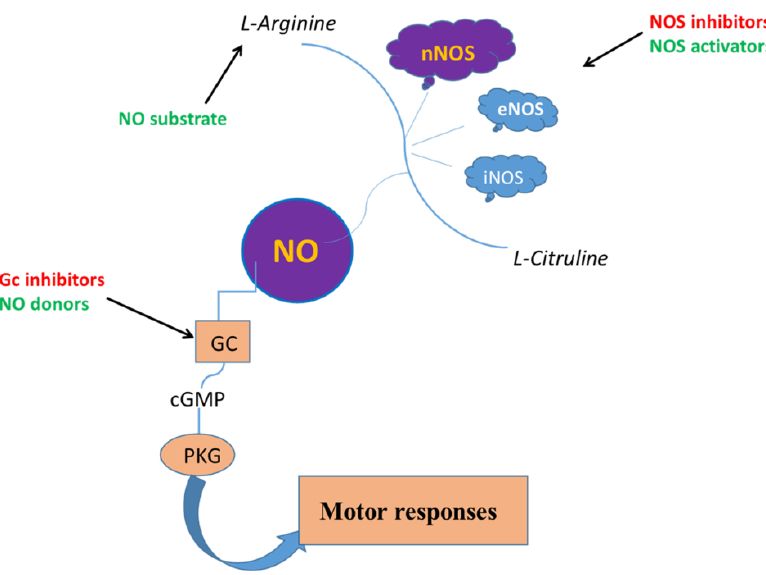
Figure 1. Simplified scheme representing the main signaling pathway through which NO influences the motor responses in the gastrointestinal tract and some possible targets for therapeutic intervention. Enhancement of NO signaling can be achieved by NO donors, by providing excess arginine substrate or enhancing signaling pathways that activate NOS functions (green color). NO signaling prevention may be achieved by guanylate cyclase (GC) function or NOS activity inhibitors (red color).